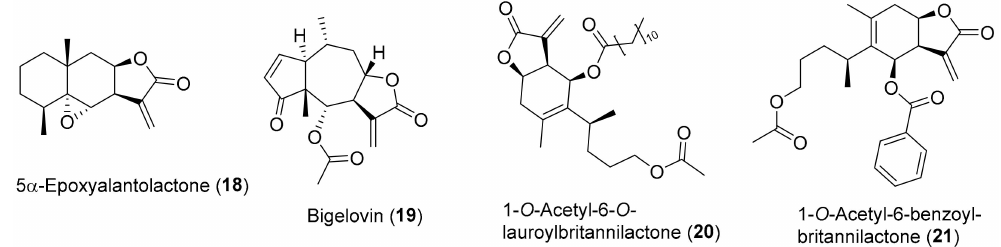
Figure 4. Chemical structure of Inula secondary metabolites ( 18 – 19 ) and semisynthetic derivatives ( 20 – 21 ) with reported activity against oxidative-stress